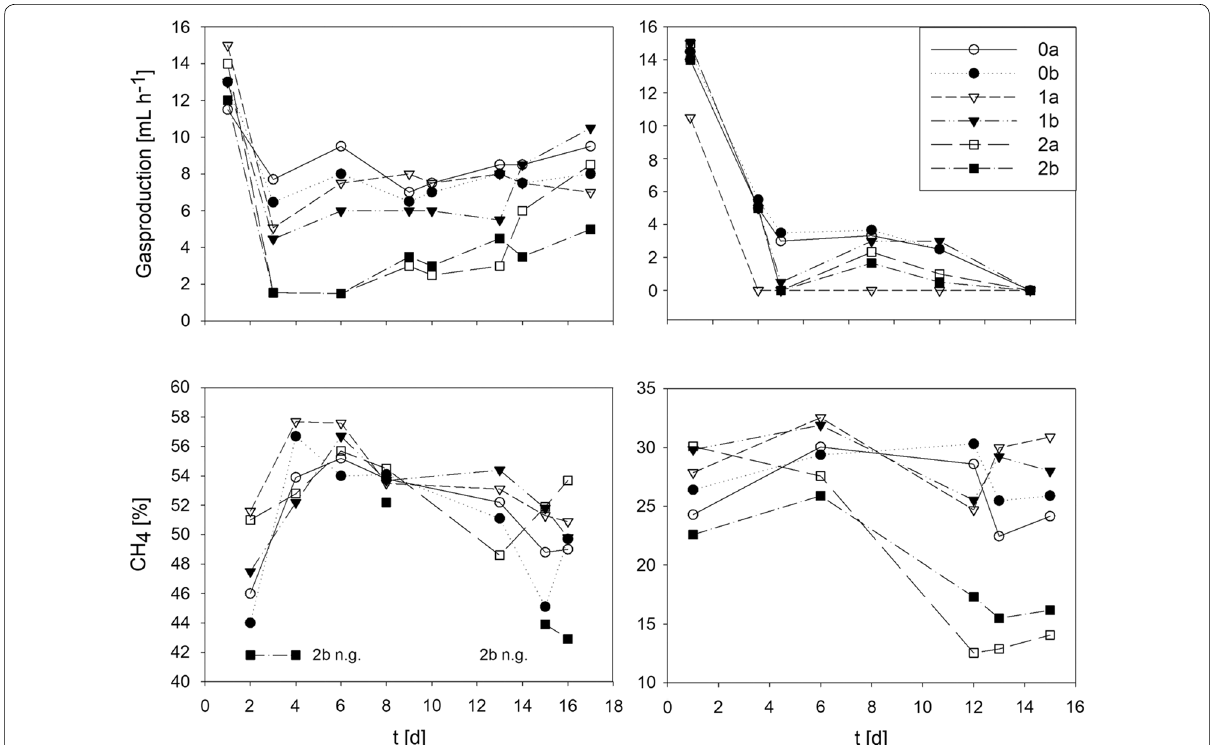
Fig. 4 Gas production and CH 4 ‑content of the gas produced by the satellite reactors. Left: satellites to biogas reactor (technical plant #1), right: satellites to sewage sludge digester technical (plant #14). Satellites 0a and b (controls) contained no additional As, satellites 1a and b contained 30 µM (2.25 mg L − 1 ) of additional As, and satellites 2a and b 60 mM (4.5 mg L − 1 ) additional As. As was added as NaAsO